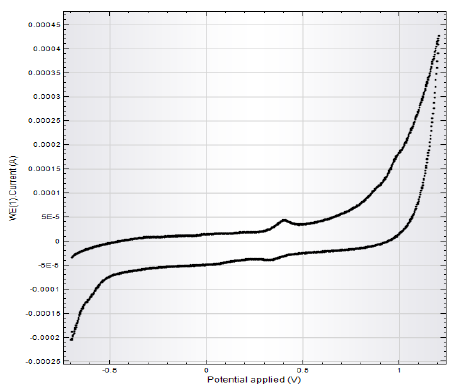
Figure A4. CV registered on graphite-based SPE in the presence of 0.5 mM DPPH ˙ in 0.1 M HClO 4 .